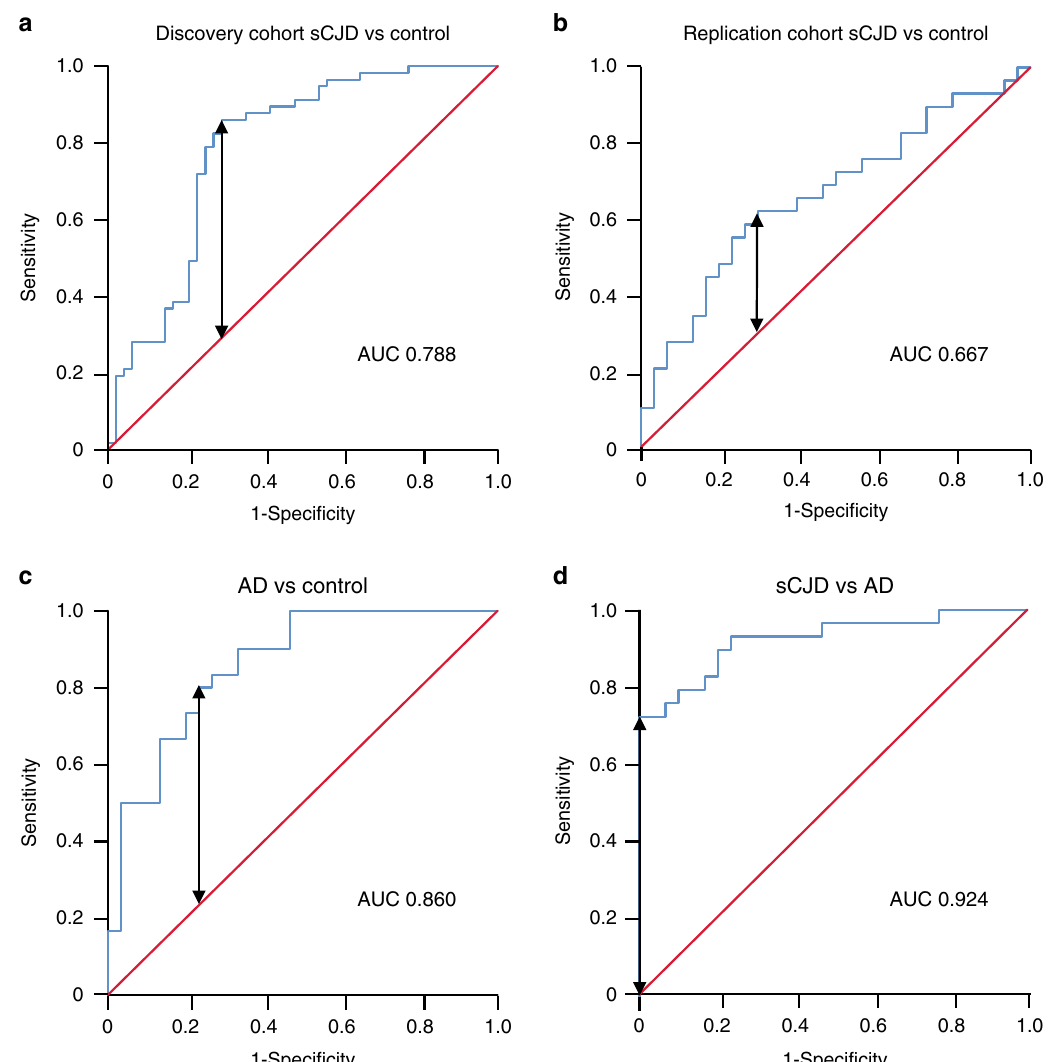
Fig. 5 Diagnostic potential of blood miRNA biomarkers. Receiver operating characteristic (ROC) curves were constructed using mean Z -scores calculated from ( a ) log-transformed normalised small RNA-seq reads in sCJD versus control individuals in the discovery study. sCJD n = 57 biologically independent samples; control n = 48 biologically independent samples; and ( b ) ratios of hsa-let-7i-5p, hsa-miR-16-5p and hsa-miR-93-5p measured relative to RNU6-2; sCJD versus control individuals in the replication study. sCJD n = 29 biologically independent samples; control n = 30 biologically independent samples; ( c ) ratios of hsa-let-7i-5p, hsa-miR-16-5p and hsa-miR-93-5p measured relative to RNU6-2; AD versus control individuals. AD n = 30 biologically independent samples; control n = 30 biologically independent samples; and ( d ) ratios of hsa-let-7i-5p, hsa-miR-16-5p and hsa-miR-93-5p measured relative to RNU6-2; sCJD versus AD. sCJD n = 29 biologically independent samples; AD n = 30 biologically independent samples. Area under the curve (AUC) is shown for each comparison; maximal Youden ’ s Index is indicated by the double headed arrow, where test performance is optimal. The line of zero discrimination is shown in red. Source data for ( a – d ) are provided as a Source Data fi